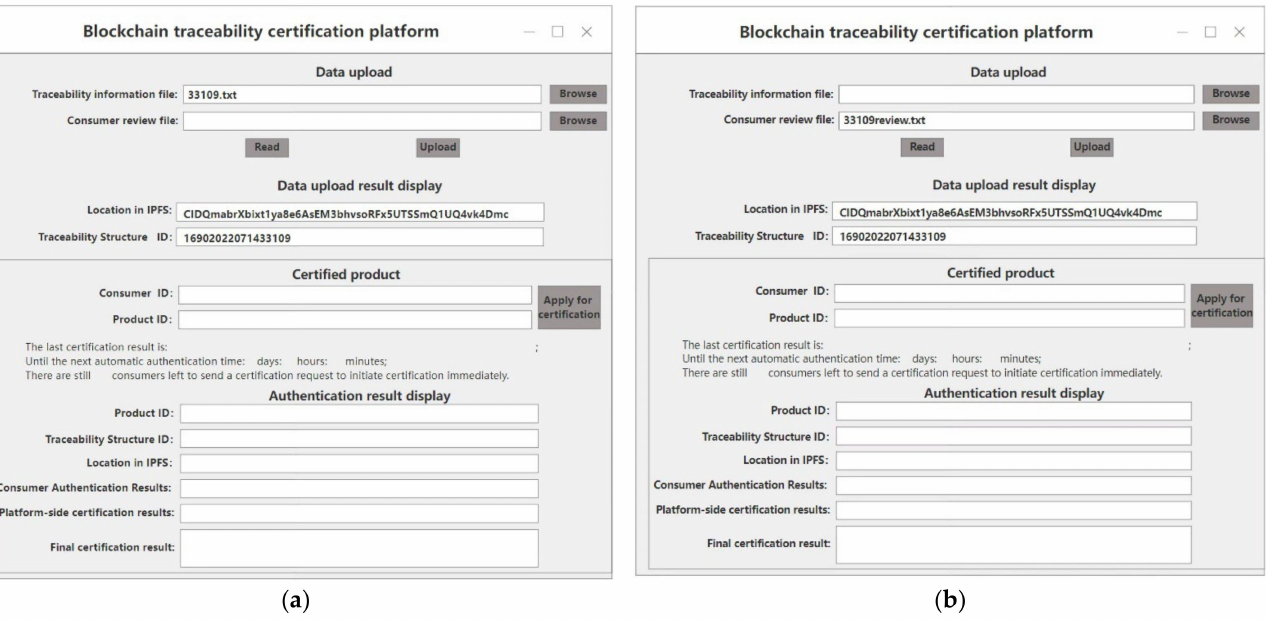
Figure 8. Information upload interface. ( a ) Traceability information file upload; and ( b ) Consumer review file upload.